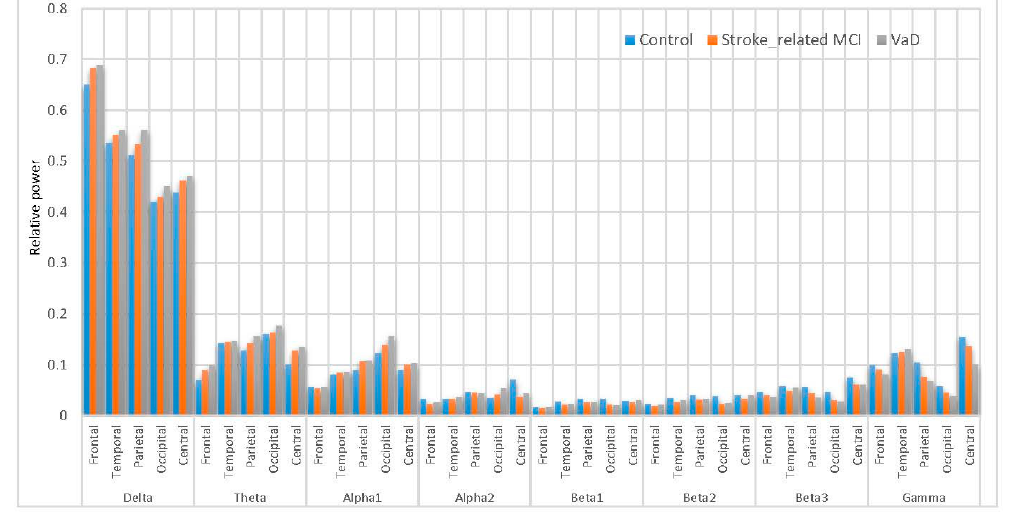
Figure 12. Comparative plot of the relative powers for the five scalp regions of the brain for VaD, Stroke related MCI patients and control subjects without using AICA–WT.